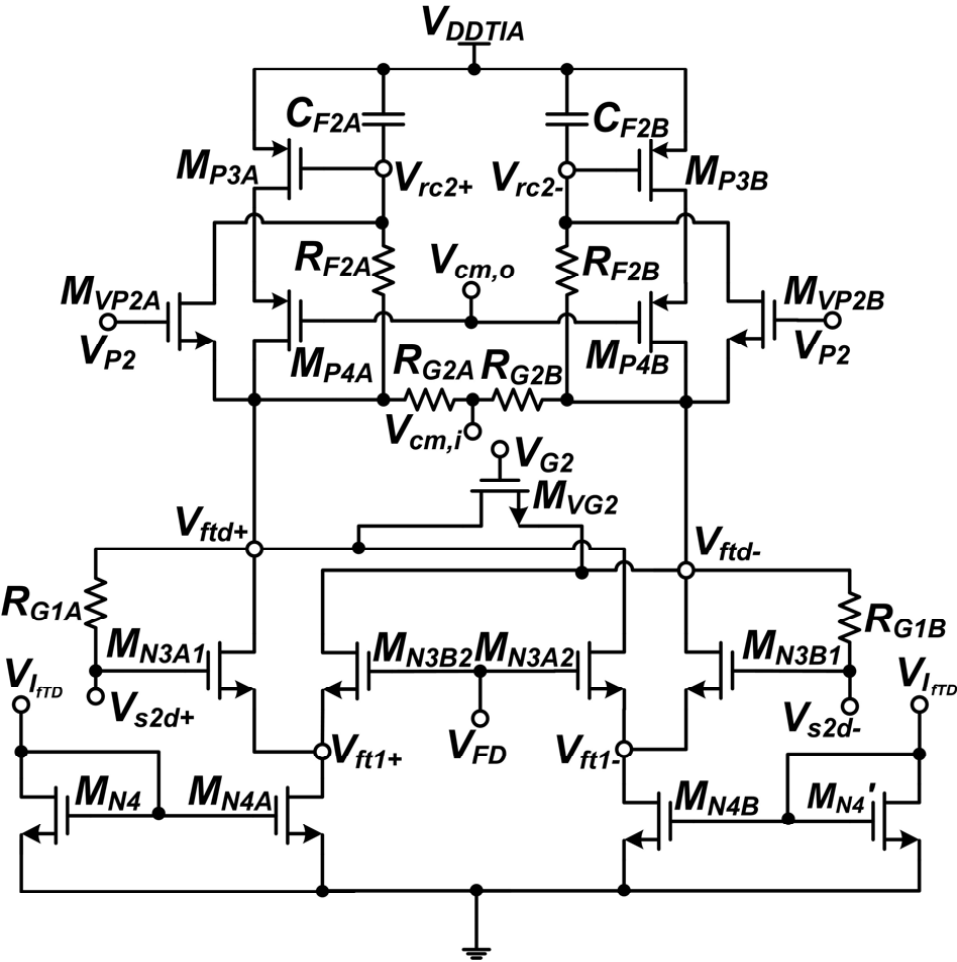
Figure 3. Schematic of the modified 𝑓